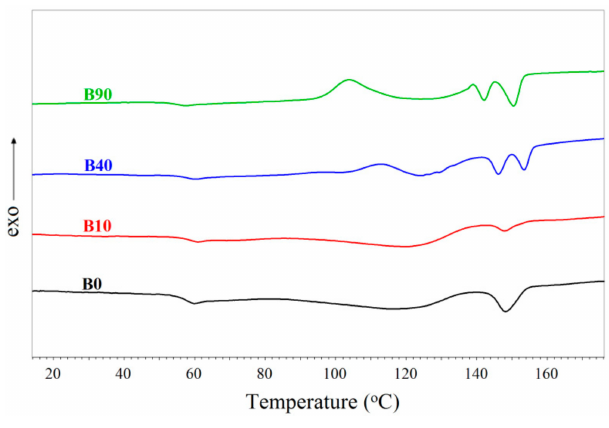
Figure 7. DSC curves recorded for the samples type B. Table 3. Data derived from the di ff erential scanning calorimeter (DSC) curves recorded for the samples type L (Figure 6) and B (Figure